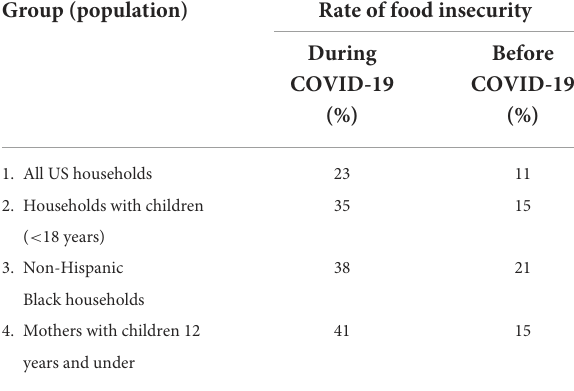
During Before COVID-19 COVID-19 (%)